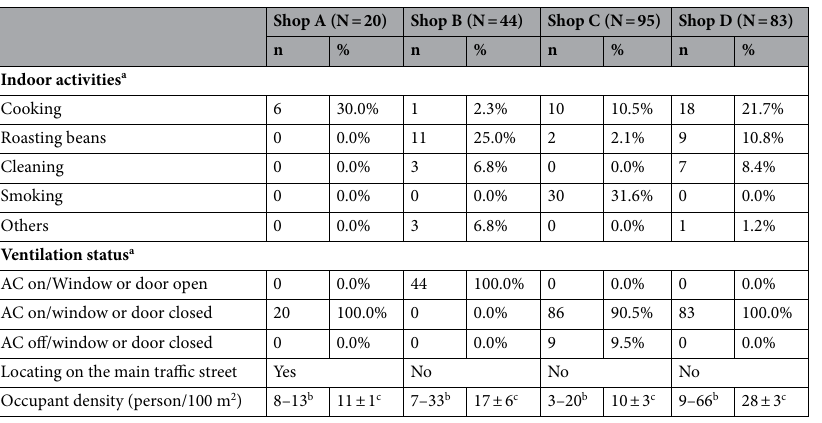
Table 2. Summary of the indoor environmental characteristics in the investigated coffee shops. AC, air conditioner. a Recorded by 15-min interval. b Range. c Mean ± SD.